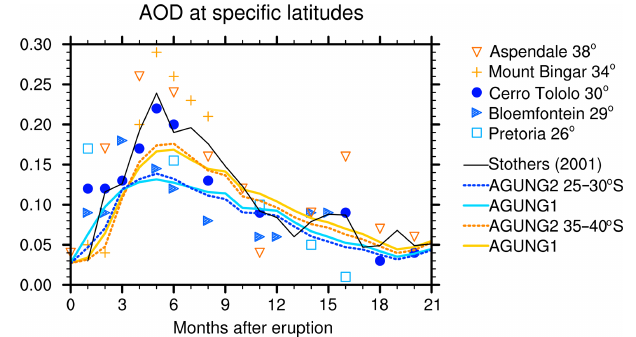
Figure 7. Monthly mean SH AOD (550µm) over time. Colored lines show model results averaged over 25 to 30 ◦ S (blue) and 35 to 40 ◦ S (orange) each for both ensembles. The black line gives data of Stothers (2001), the average of measurements between 20 and 40 ◦ S. Single markers show single measurement data, estimated from Fig. 1 in Stothers (2001), with a similar color code to the model